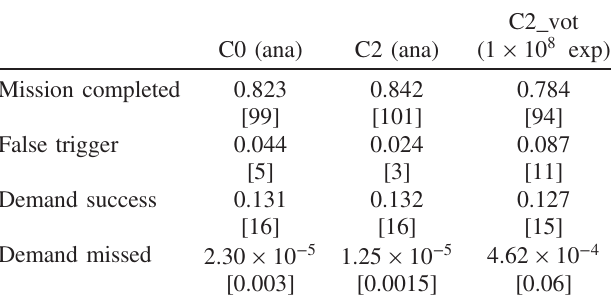
TABLE VIII. Case III: Scenario probabilities for the different architectures. Default input parameters for all components (in- cluding voting), analytical (ana), and explicit simulation (exp). In brackets: number of expected occurrences during lifetime (20 years and 6 cycles per year).